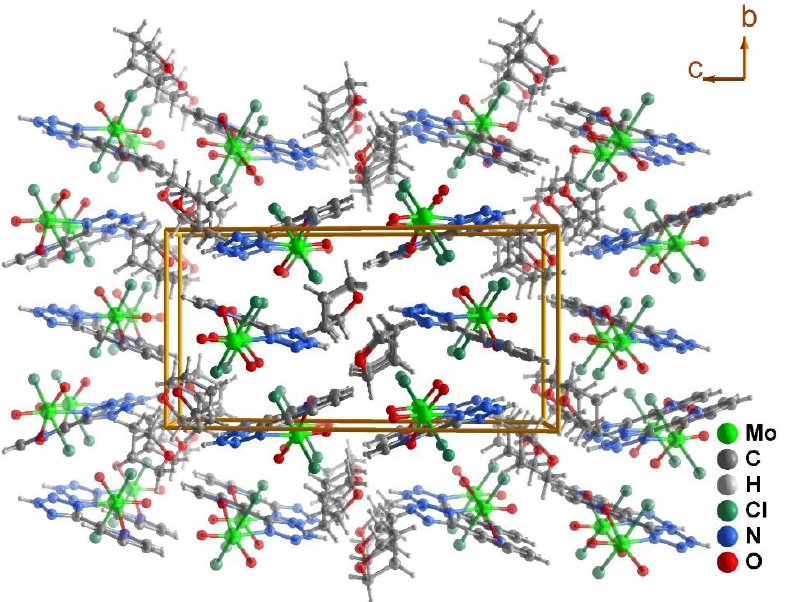
Figure 2. Schematic representation, with selected atomic labelling, of the asymmetric unit of com- pound [MoO 2 Cl 2 (Hpto)]·THF ( 1 ), showing all non-hydrogen atoms as displacement ellipsoids drawn at the 70% probability level and hydrogen atoms as small spheres with arbitrary radii. The hydrogen bonding interaction between the molybdenum complex and the THF molecule is depicted as a dashed orange line. Selected bond distances (Å): Mo1-Cl1 2.4012(6); Mo1-Cl2 2.3623(6); Mo1- N1 2.339(1); Mo1-O1 2.155(1); Mo1-O2 1.704(1); Mo1-O3 1.689(2); N5-O1 1.334(2). Selected bond angles (°): O3-Mo1-O2 104.53(7); O3-Mo1-O1 160.38(6); O2-Mo1-O1 95.04(6); O2-Mo1-N1 167.60(6); O3-Mo1-N1 87.62(6); Cl1-Mo1-Cl2 159.811(17); O1-Mo1-N1 72.77(5); Mo1-O1-N5 130.93(10).